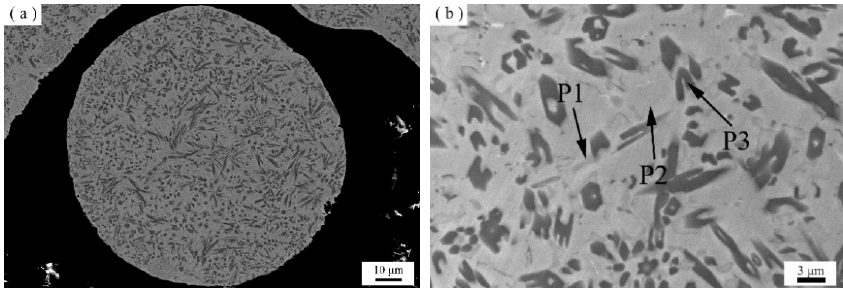
Figure 4. Cross section morphology ( a ) and microstructure ( b ) of the alloyed powder.